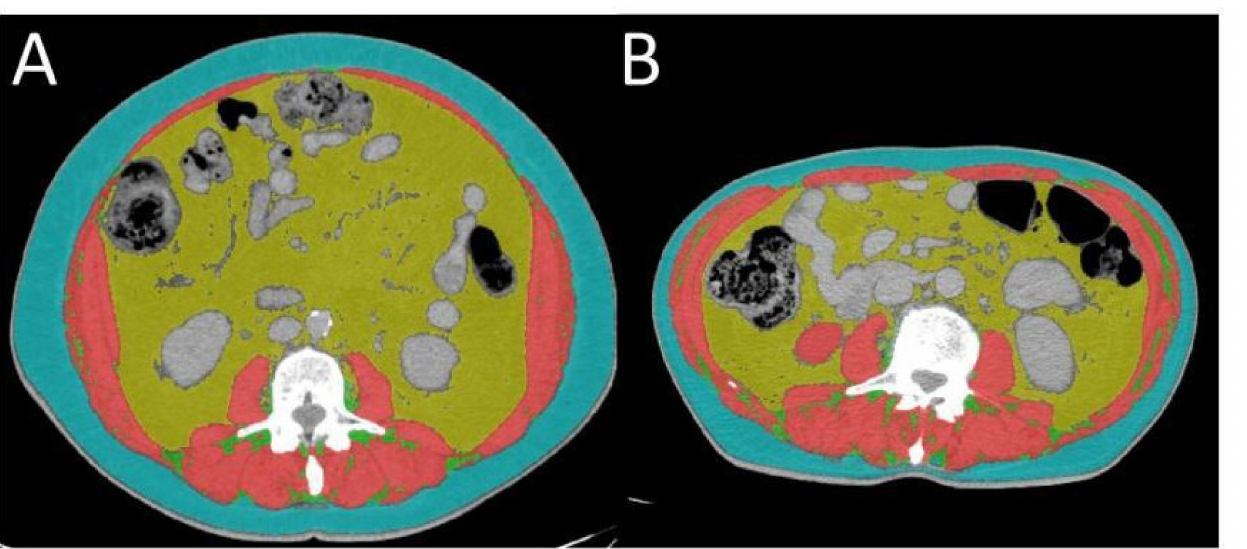
Figure 3. Evaluation of body composition. An axial CT image segmented into the skeletal muscle area (SKM in red), visceral adipose tissue area (VAT in yellow) and subcutaneous adipose tissue area (SAT in green). Total adipose tissue area (TAT) is identified from VAT + SAT. ( A ) and ( B ) differ from body